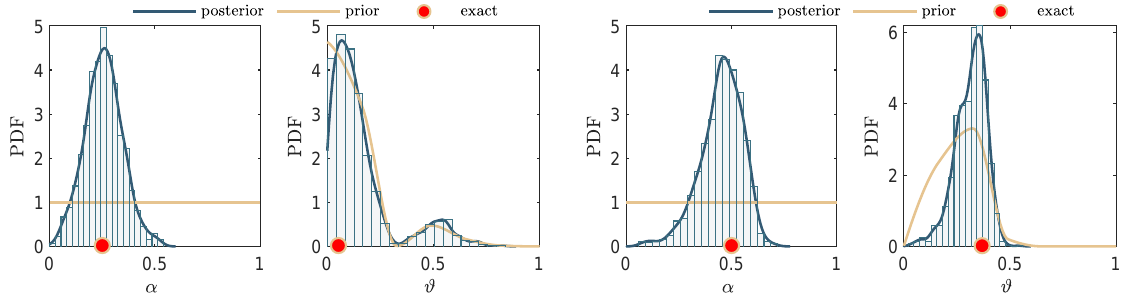
Figure 6. Identified damage severity ˆ α , and damage location ˆ ϑ , using the frequency-based algorithm for ( noise = 5% ) : ϑ = 0.05, and α = 25% ( left ); ϑ = 0.37, and α = 50% ( right ).